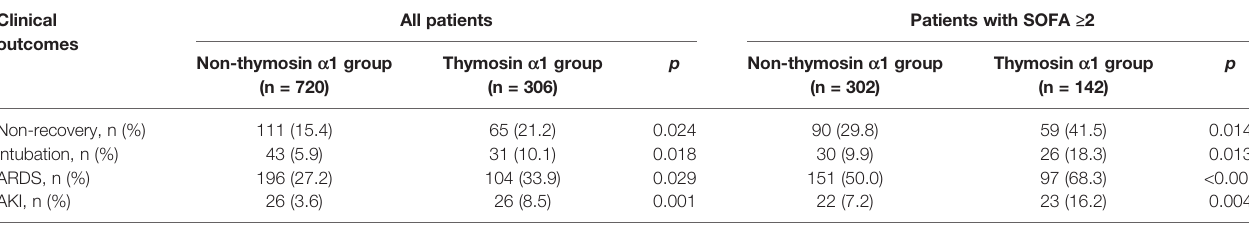
TABLE 4 | Comparisons of clinical outcomes after propensity score